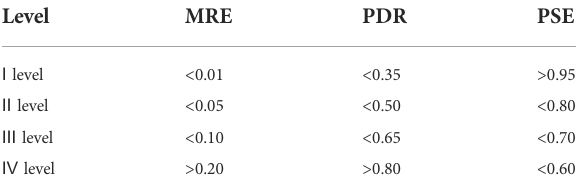
TABLE 1 Predictive model test